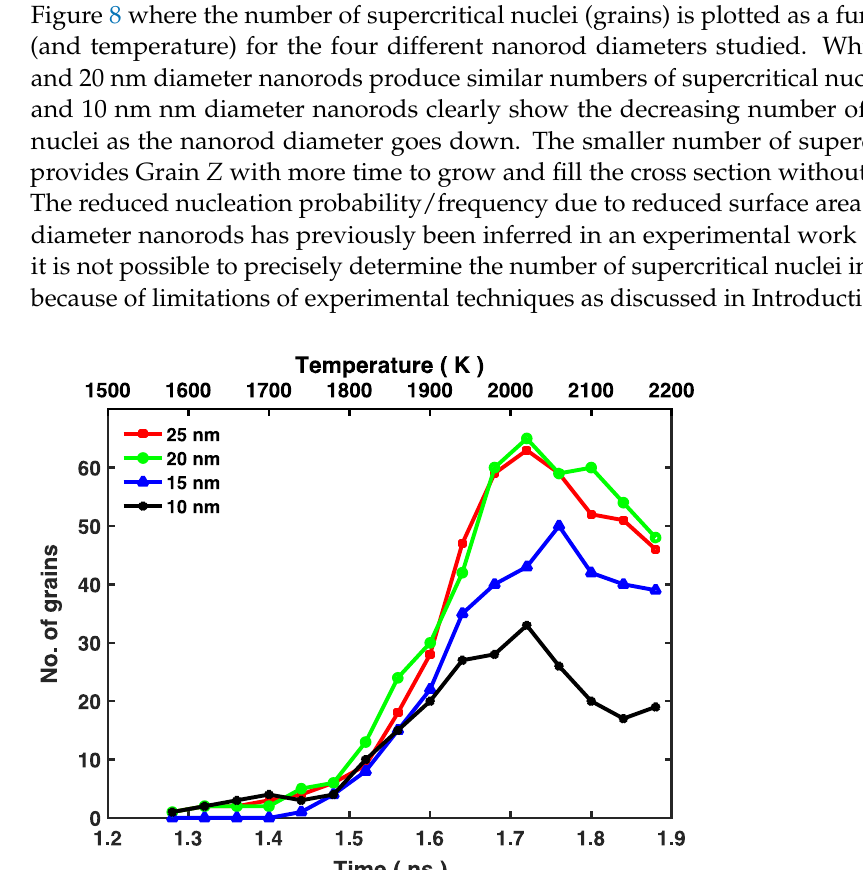
Figure 8. Number of supercritical nuclei (grains) as a function of time (and temperature) for the nanorods of different diameters (the drop past the peaks is due to coarsening/merging of the grains with continuously increasing temperature).